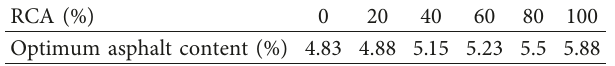
Table 5: Optimum asphalt content for WRU mixes.